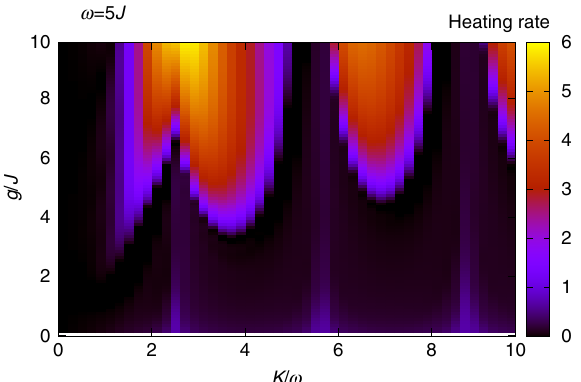
FIG. 5. Heating rate, obtained by fitting the exponential growth of the energy in Fig. 4. The resulting diagram is very similar to the instability diagram (Fig. 2), up to an overall numerical factor ≈ 2 (see